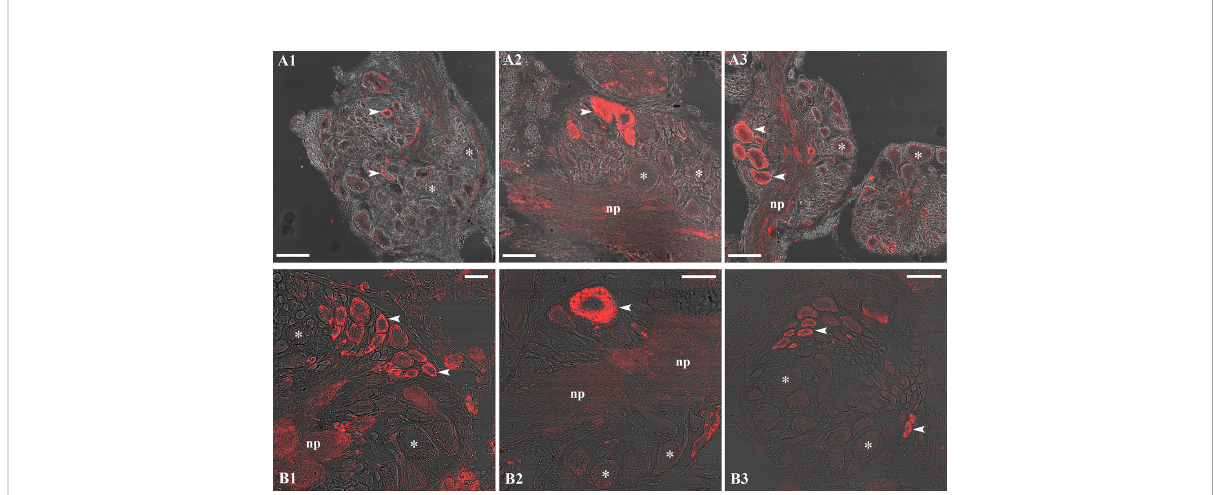
FIGURE 3 Representative CYP19A (A1-A3) and nPR (B1-B3) immunolabeling (red) in the CNS. The anti-human CYP19A antibody yielded a positive signal, for example, in the right cerebral (A1) , right pleural (A2) , and right parietal (A3) ganglia, while the anti-human nPR antibody gave immunoreactivity, for example, in the left pedal (B1) and visceral (B2, B3) ganglia. Arrowhead: labeled neuron(s); asterisk: unlabeled neuron(s); np: neuropil. Scale=100 µm (A1, A3, B2, B3) and 50 µm (A2, B1) .